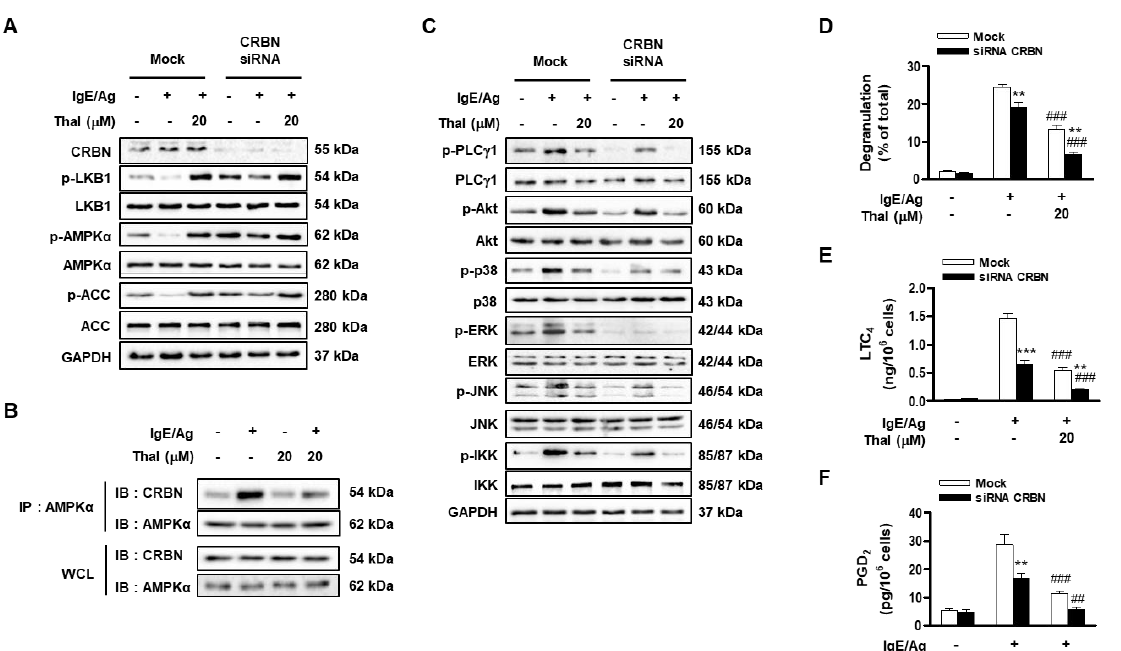
Figure 3. CRBN knockdown enhances the inhibitory effects of thalidomide on IgE/Ag-stimulated mast cell activation. IgE-sensitized BMMCs were transfected with CRBN siRNA or